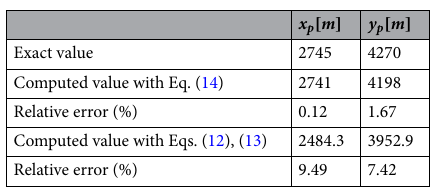
Table 2. Point-source location identification with stationary and transient equations.